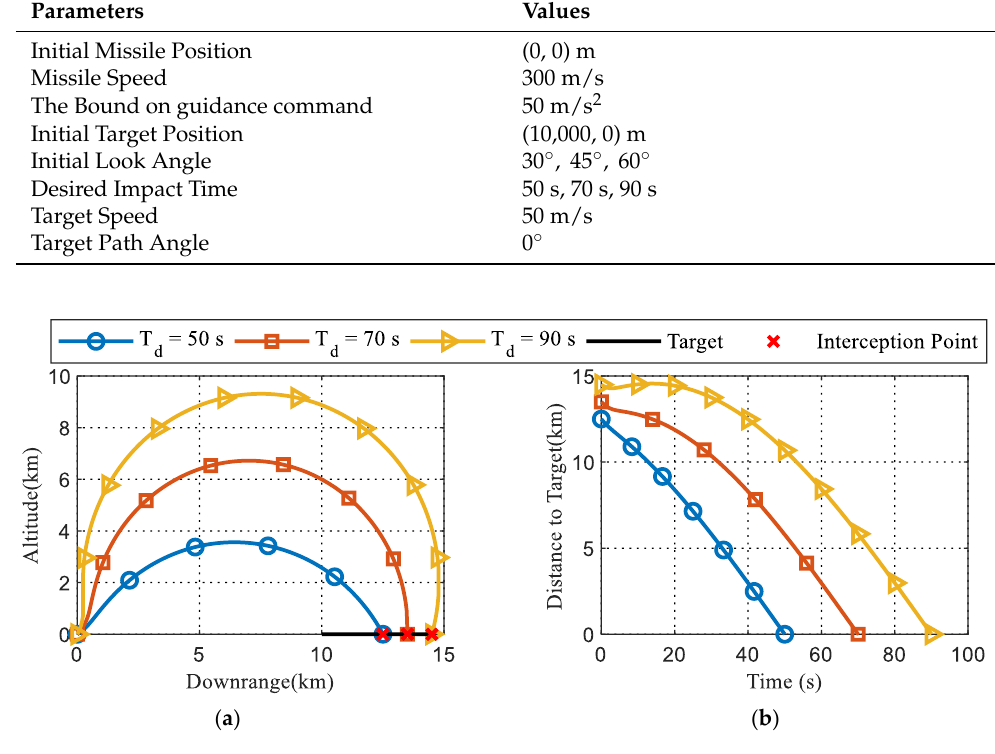
Figure 15. The results for a moving target. ( a ) Trajectories; ( b ) Distance to target.